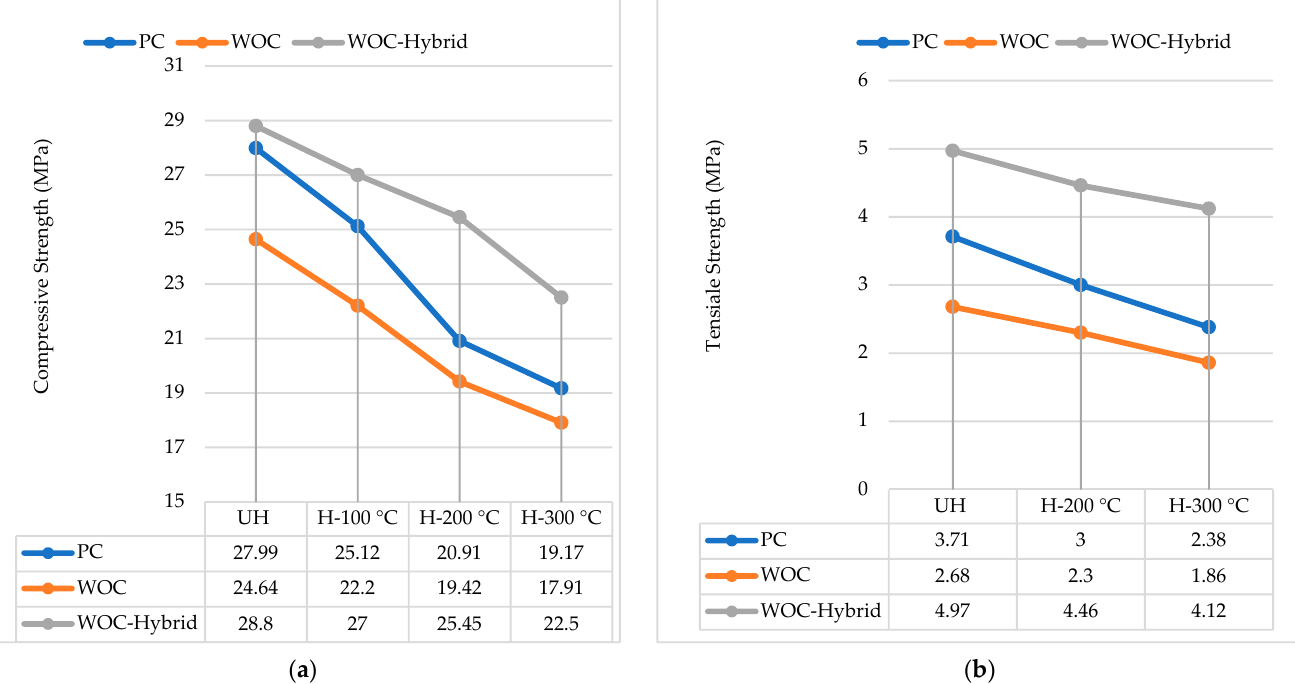
Figure 11. Average ( a ) compressive ( b ) tensile strength for various mixes.